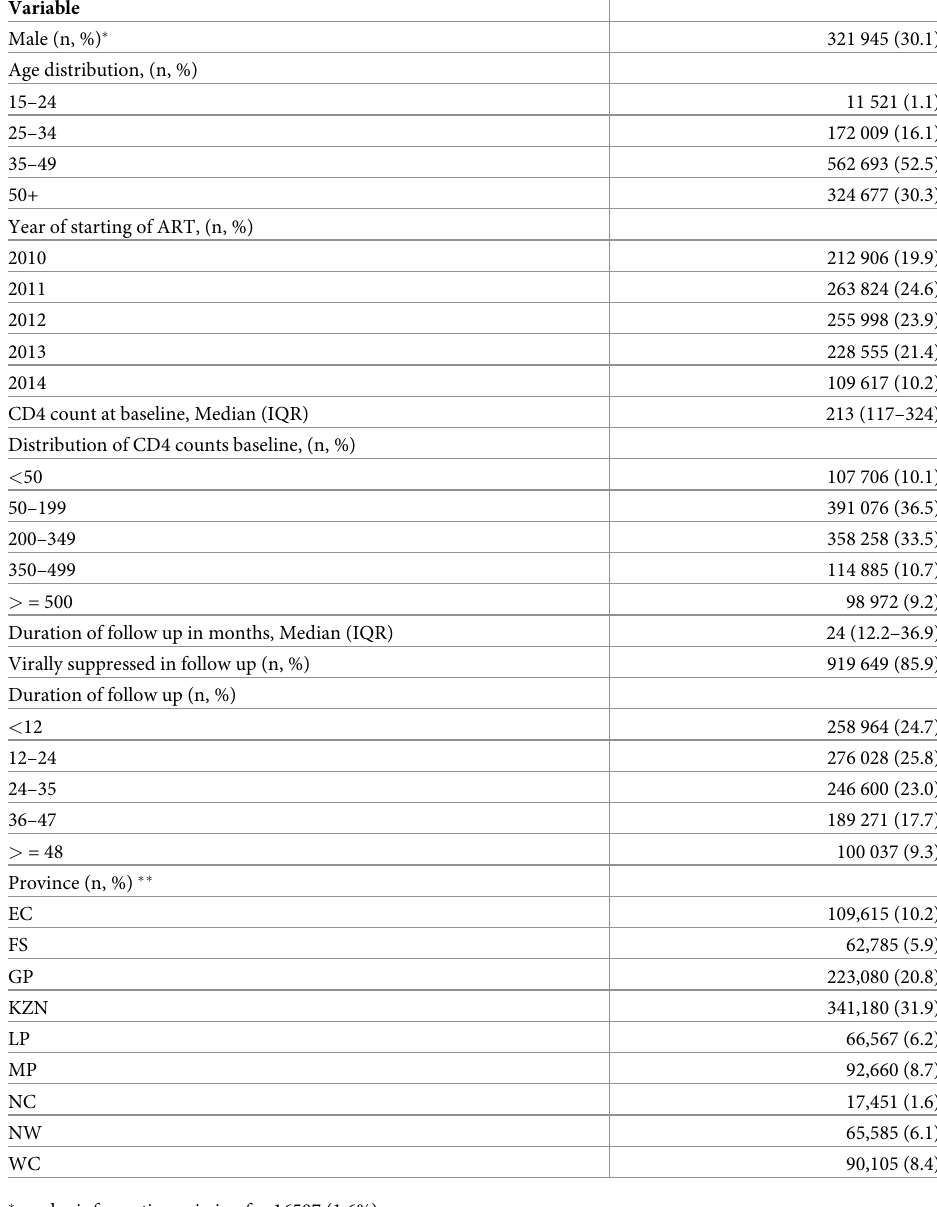
Table 1. Description of population included in the analysis (N = 1 070